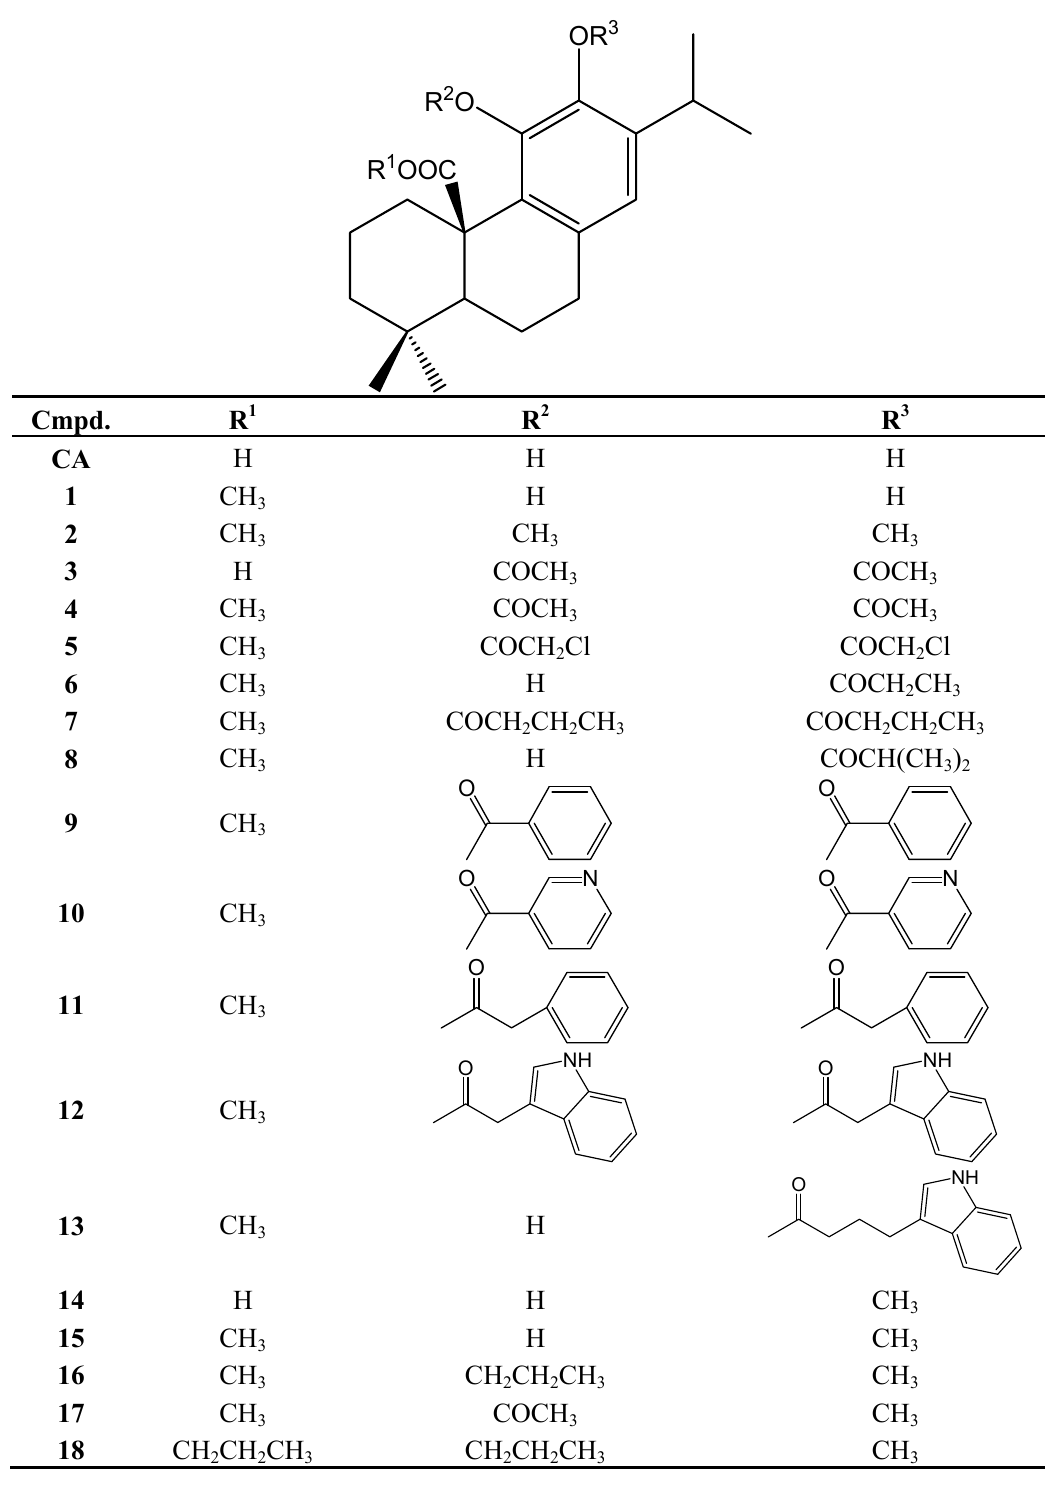
Figure 1. Structure of carnosic acid (CA) and its semisynthetic derivatives 1 – 18 .